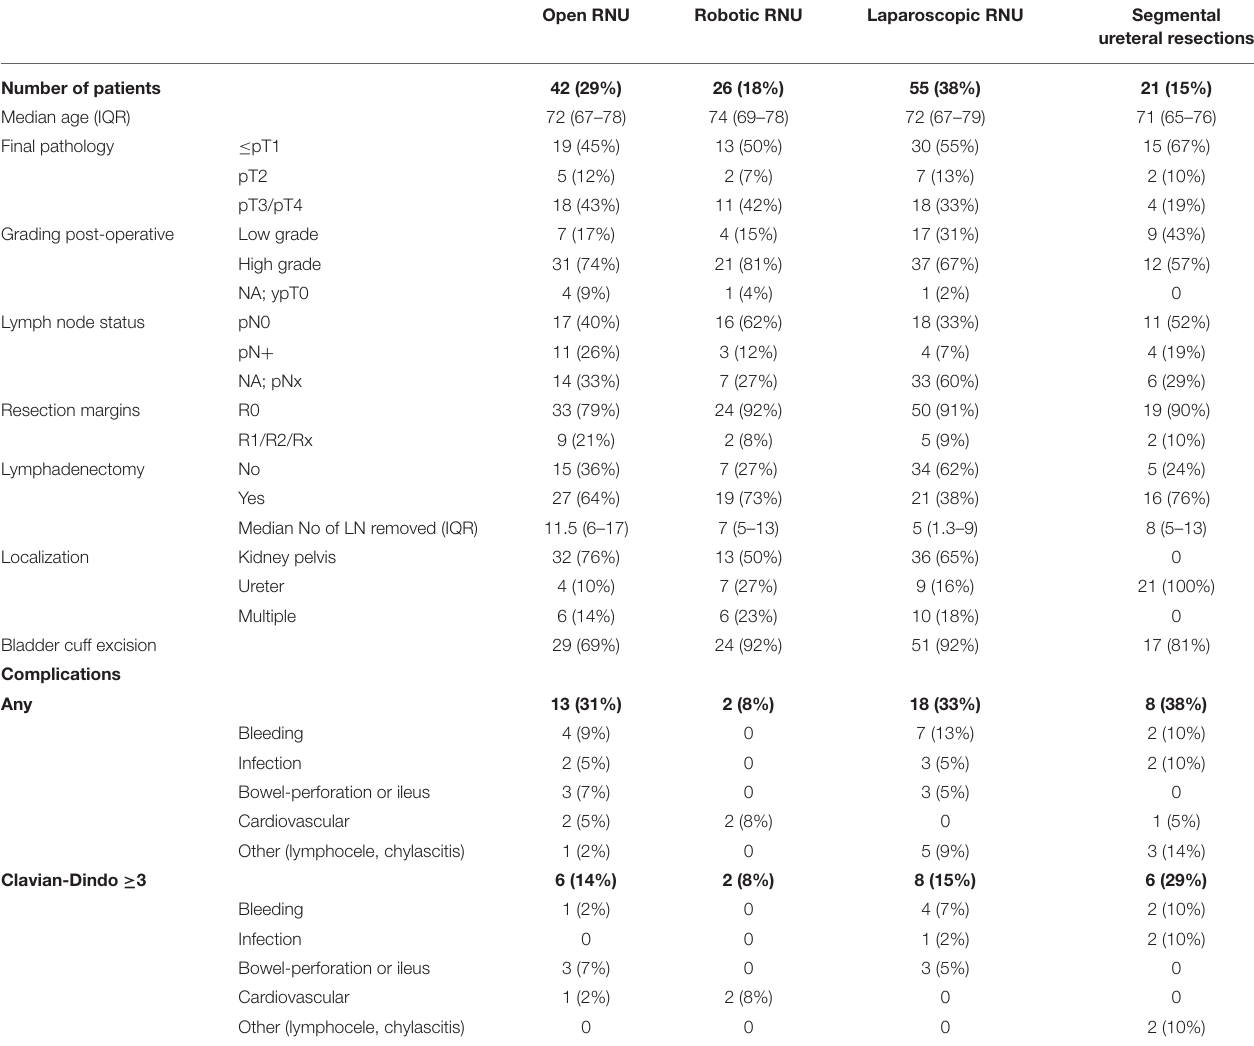
TABLE 1 | Patient and surgical characteristics with 30-Day post-operative complications specified for all complications and Clavien–Dindo grade ≥ 3 stratified by surgical technique. Open RNU Robotic RNU Laparoscopic RNU Segmental